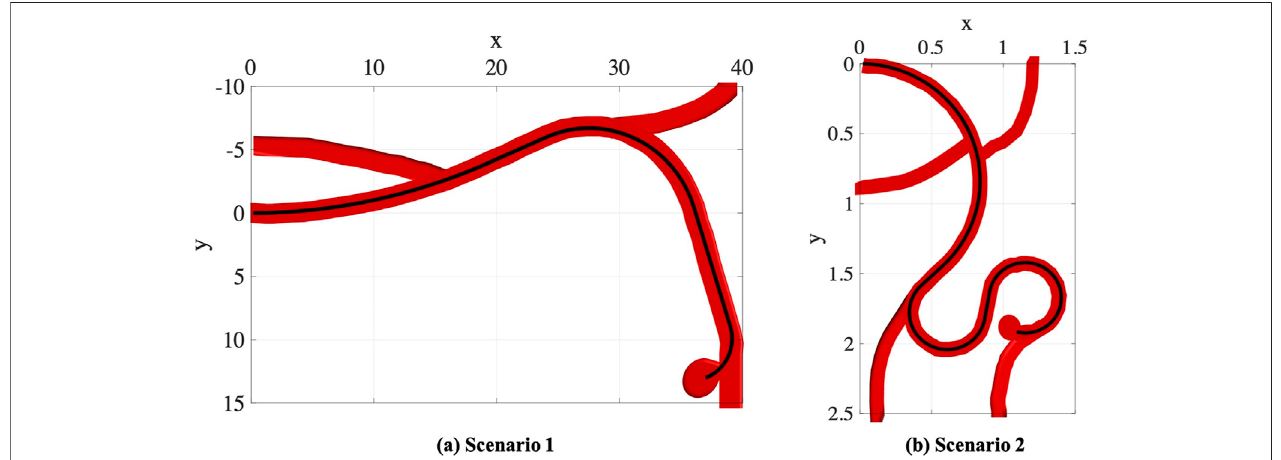
FIGURE 6 | Simulated Single-Trajectory Scenarios (all dimensions are in cm